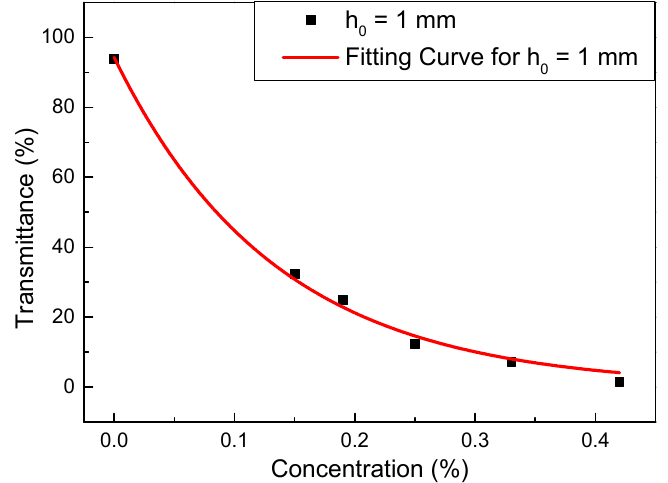
Figure 3. Transmittance characterization versus microcrystalline graphite powder concentration for samples with the same thickness ( h 0 = 1 mm).